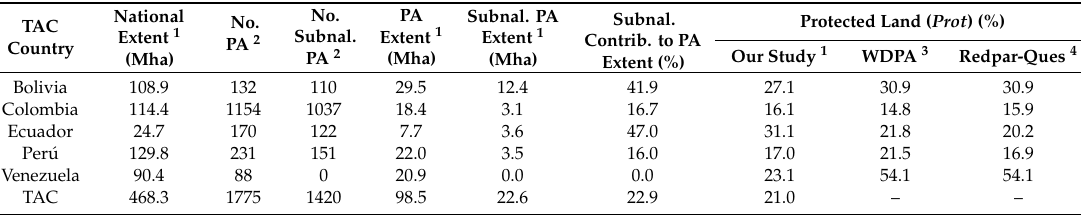
Table 1. Tropical Andean Countries (TAC) national and subnational protected areas (PAs): count, extension, and terrestrial